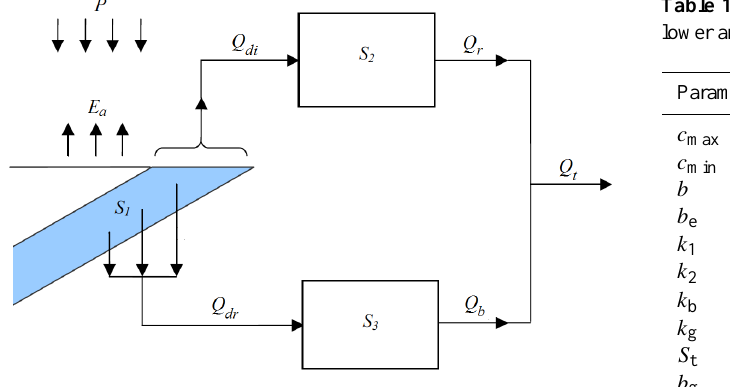
Fig. 1. General model structure of the PDM (Moore, 2007).